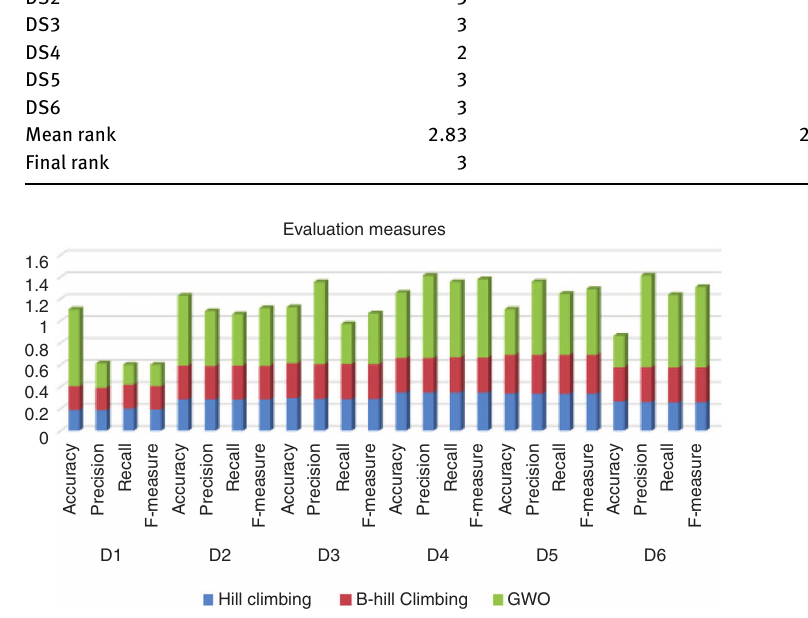
Figure 3: Comparison Between TCP-GWO and Other Comparative Approaches. method, statistically, exhibited a respectable level of performance, much better than the TCP-hill climbing and TCP- β -hill